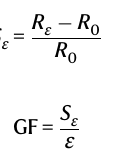
Fig. 2 | Crack propagation behaviors of M n sensors with homogenous and heterogenoustopographies.a FEAsimulationsofstraindistributionpro fi lesof M p and M w nanolayers. b Re fl ection-contrastmicroscopyimagesof M p and M w sensors for in situ observation of their crack propagation behaviors. c FEA simulations of